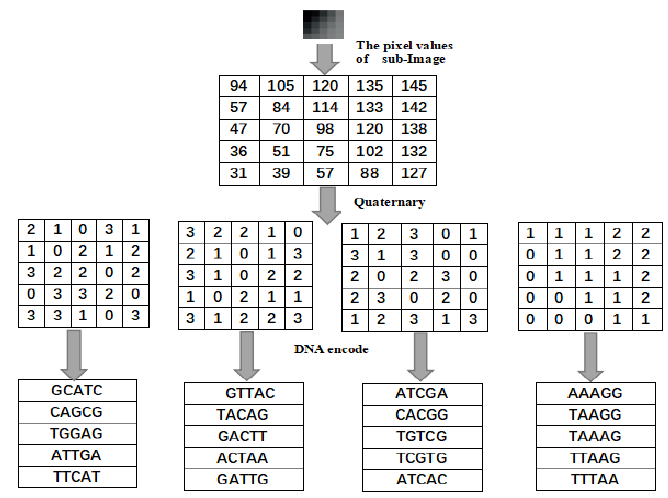
Figure 2. DNA Figure 2. DNA encoding.